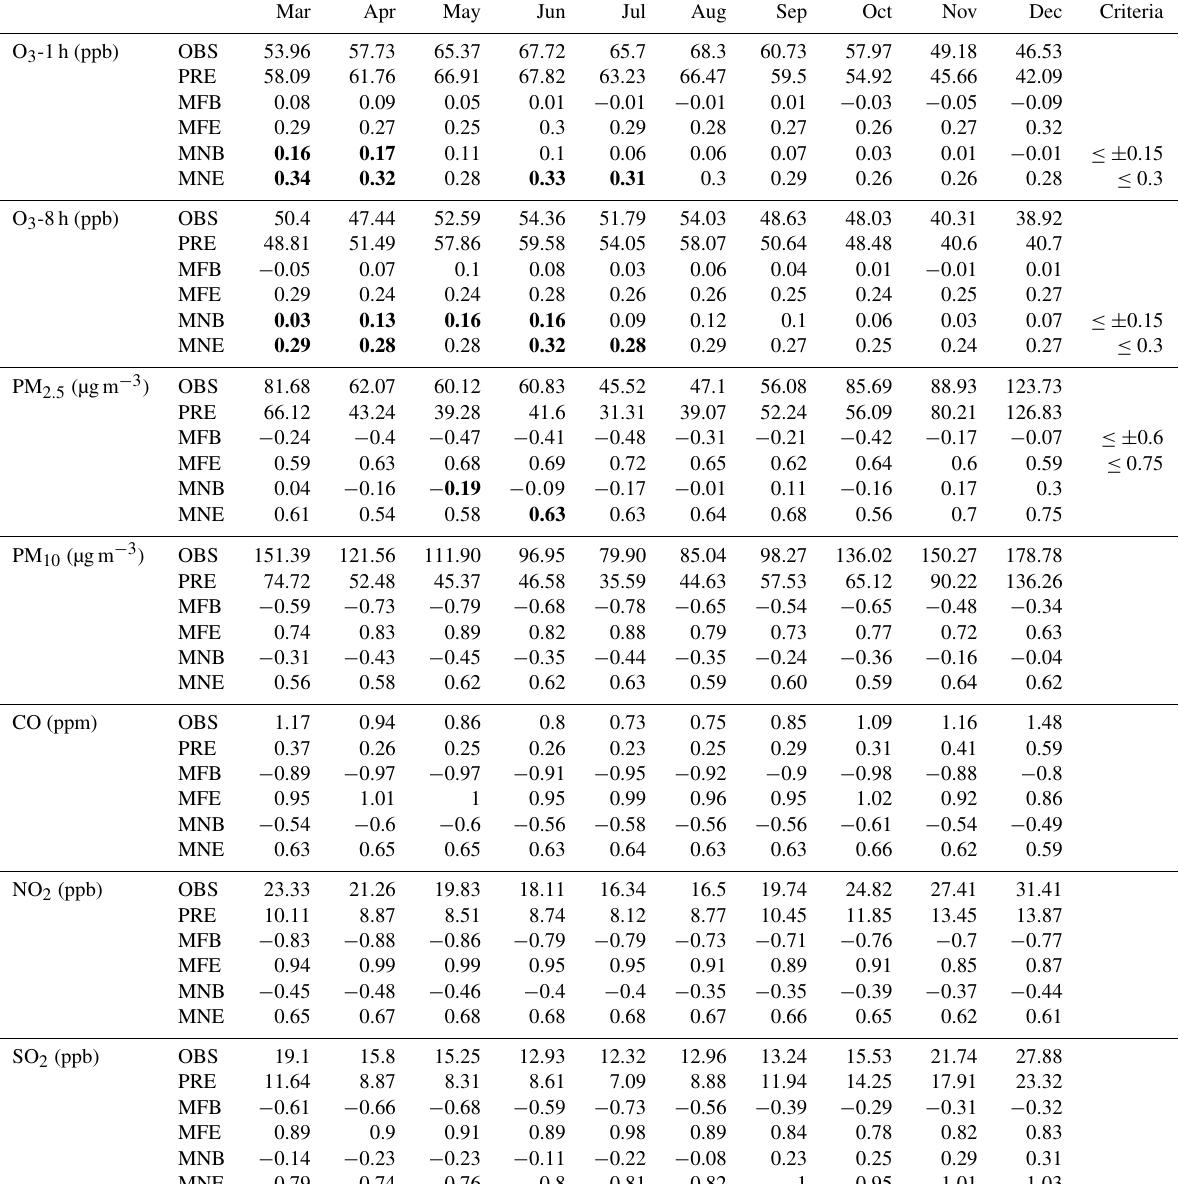
Table 3. Model performance on O 3 -1h, O 3 -8h, PM 2 . 5 , PM 10 , CO, NO 2 , and SO 2 in March to December 2013 (OBS is mean observation; PRE is mean prediction; MFB is mean fractional bias; MFE is mean fractional error; MNB is mean normalized bias; MNE is mean normalized error). The performance criteria for PM 2 . 5 are suggested by EPA (2007), and the performance criteria for O 3 are suggested by EPA (2005). The values that do not meet the criteria are denoted in